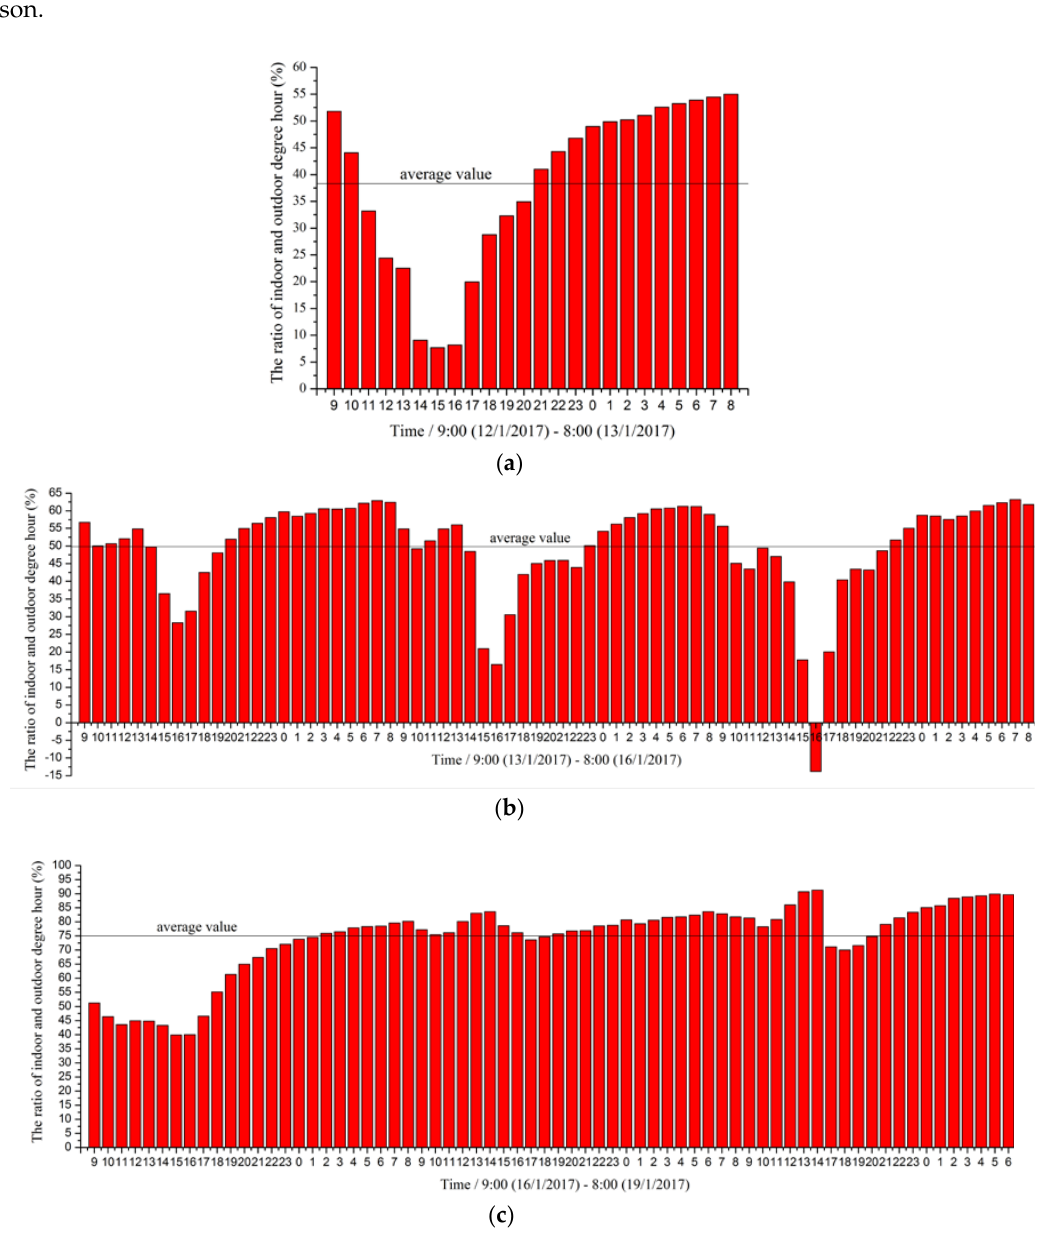
Figure 7. The ratio of indoor and outdoor degree hour with different strategies. ( a ) Reference condition; ( b ) Passive solar heating condition; ( c ) Active solar heating condition.